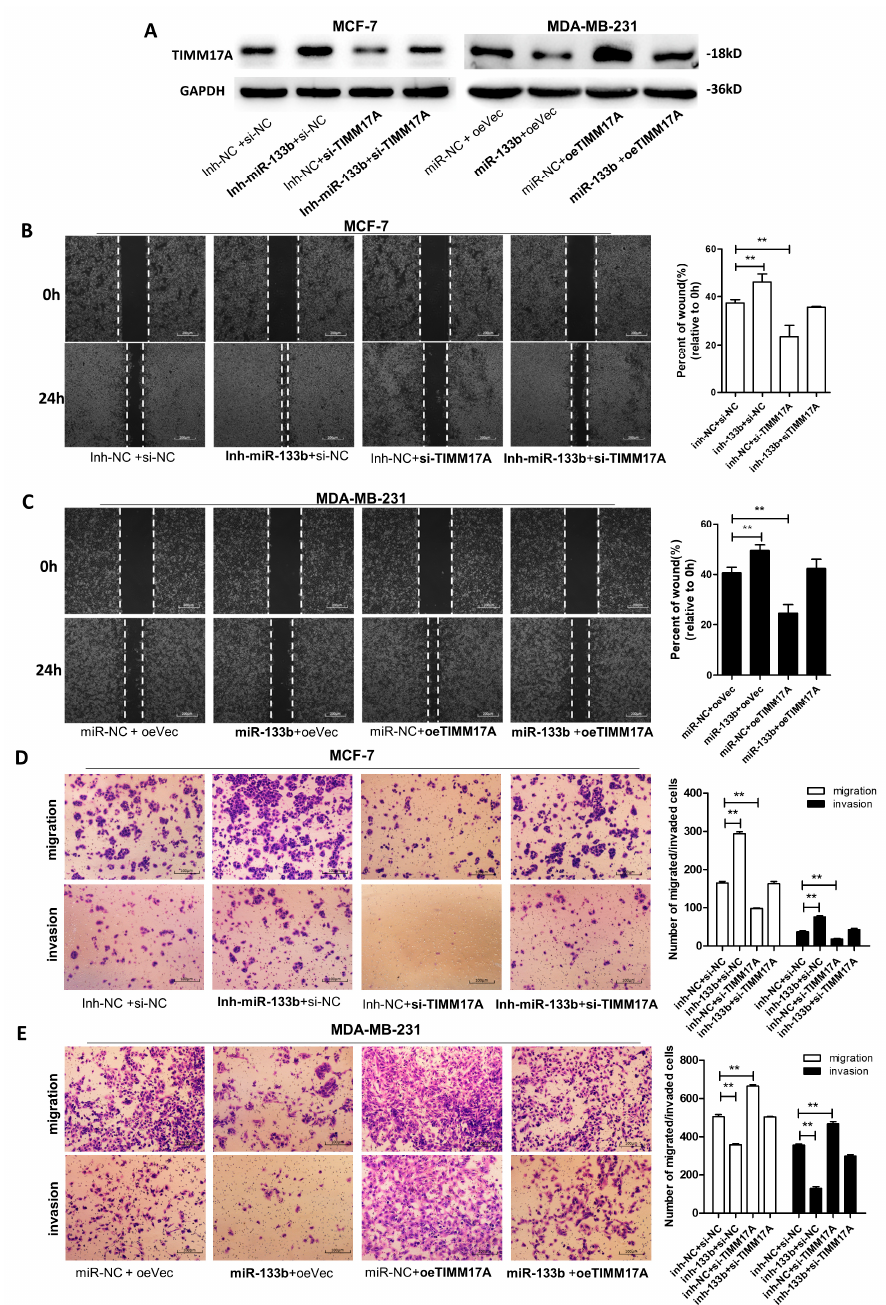
Figure 1. miR-133b promotes breast cancer cell migration and invasion via targeting TIMM17A ( A ) TIMM17A protein levels in MCF-7 cells transfected with inh-NC plus control siRNA(si-NC), inh- miR-133b plus si-NC, inh-NC plus TIMM17A siRNA (si-TIMM17A), or inh- miR-133b plus si-TIMM17A, and in MDA-MB-231 cells transfected with miR-NC plus control vector(oeVec), miR-133b plus oeVec, miR-NC plus TIMM17A vector (oeTIMM17A), or miR-133b plus oeTIMM17A. ( B , C ) Migration of MCF-7 cells transfected with inh-NC plus control siRNA(si-NC), inh- miR-133b plus si-NC, inh-NC plus TIMM17A siRNA (si-TIMM17A), or inh- miR-133b plus si-TIMM17A ( B ), and MDA-MB-231 cells transfected with miR-NC plus control vector(oeVec), miR-133b plus oeVec, miR-NC plus TIMM17A vector (oeTIMM17A), or miR-133b plus oeTIMM17A ( C ) detected by wound healing assay. Scale bar, 100 µ m. ( D , E ) Migration and invasion of MCF-7 cells transfected with inh-NC plus control siRNA(si-NC), inh- miR-133b plus si-NC, inh-NC plus TIMM17A siRNA (si-TIMM17A), or inh- miR-133b plus si-TIMM17A ( D ), and MDA-MB-231 cells transfected with miR-NC plus control vector(oeVec), miR-133b plus oeVec, miR-NC plus TIMM17A vector (oeTIMM17A), or miR-133b plus oeTIMM17A ( E ) detected by transwell migration and invasion assay. Scale bar, 100 µ m. ** p < 0.01; *** p <